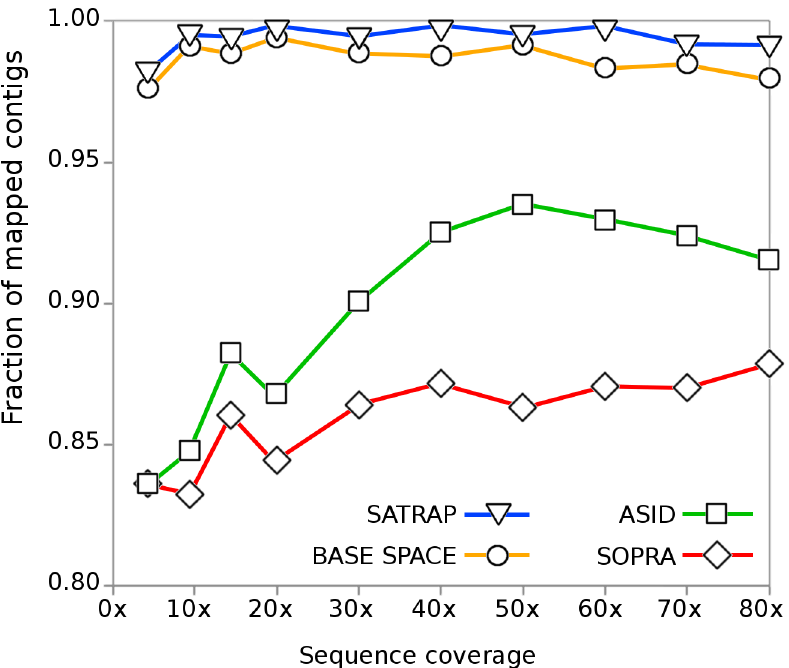
Fig 2. Effect of sequence coverage on color translation. ASID, SATRAP and SOPRA were used to translate the color-space assemblies produced at different sequence coverage into base-space. The same set of reads was also assembled in base-space as a control.